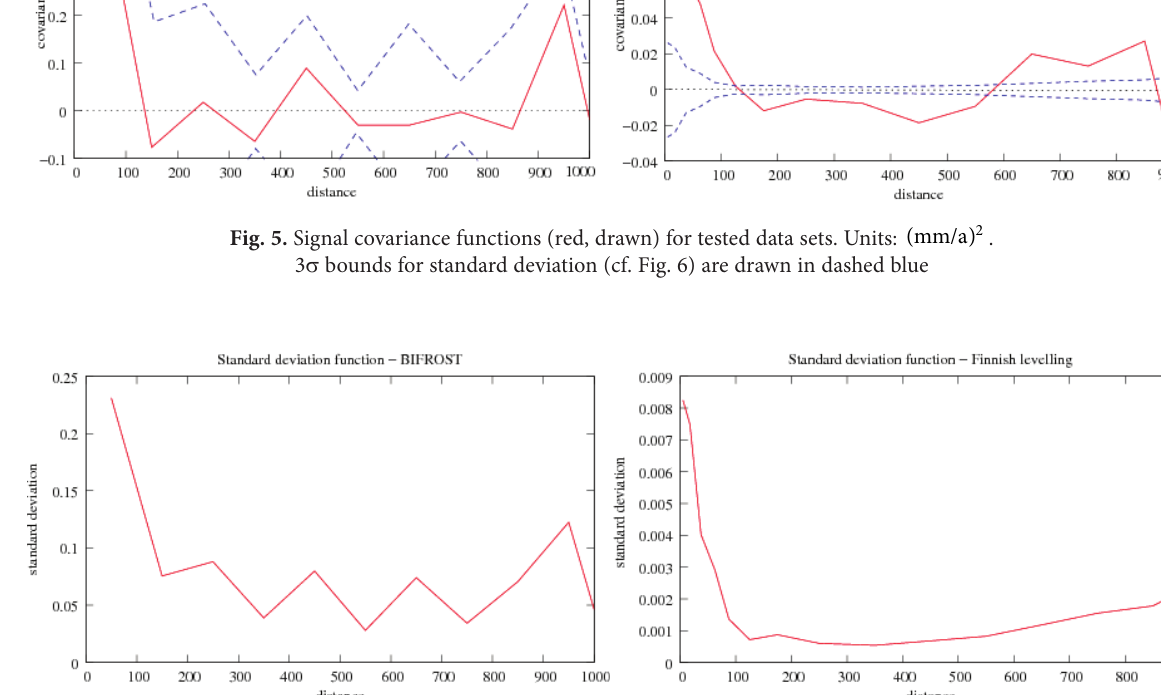
Fig. 6. Standard deviation functions for the covariance estimator functions of the tested data sets. These functions represent statistical uncertainty using which empirical covariance values presented in Fig. 5 were obtained. Units: 2 (mm/a)